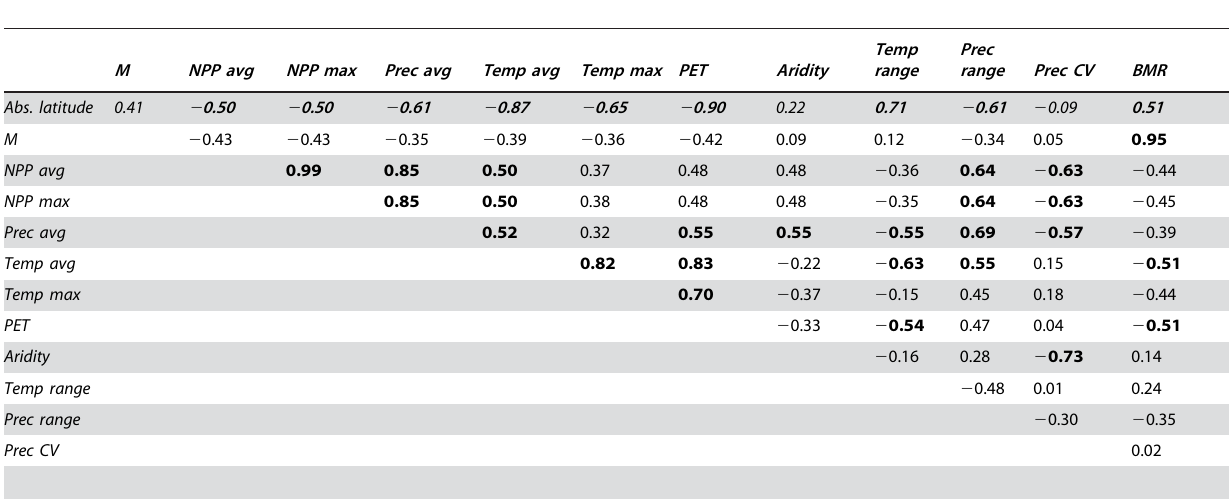
Table 1. Correlation matrix of environmental variables and species traits in the